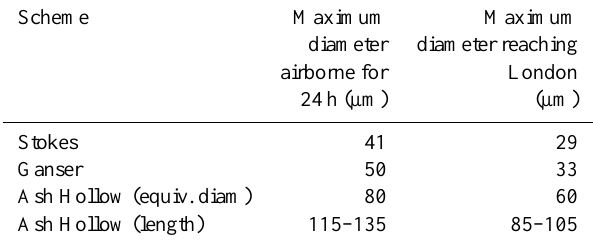
Table 5. Summary of transport model results. Ash Hollow results are based on particles of rhyolite composition.